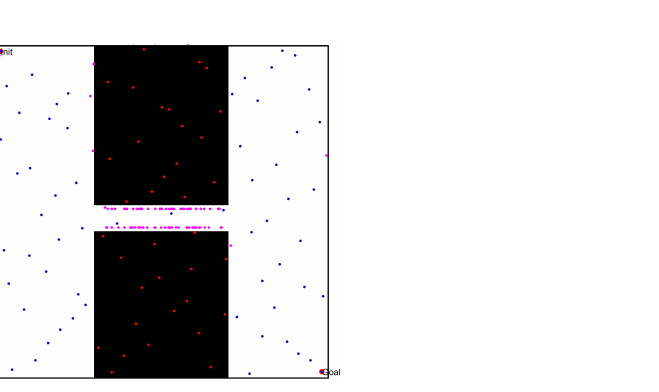
Figure 14. Optimization results of the obstacle points in the potential map.